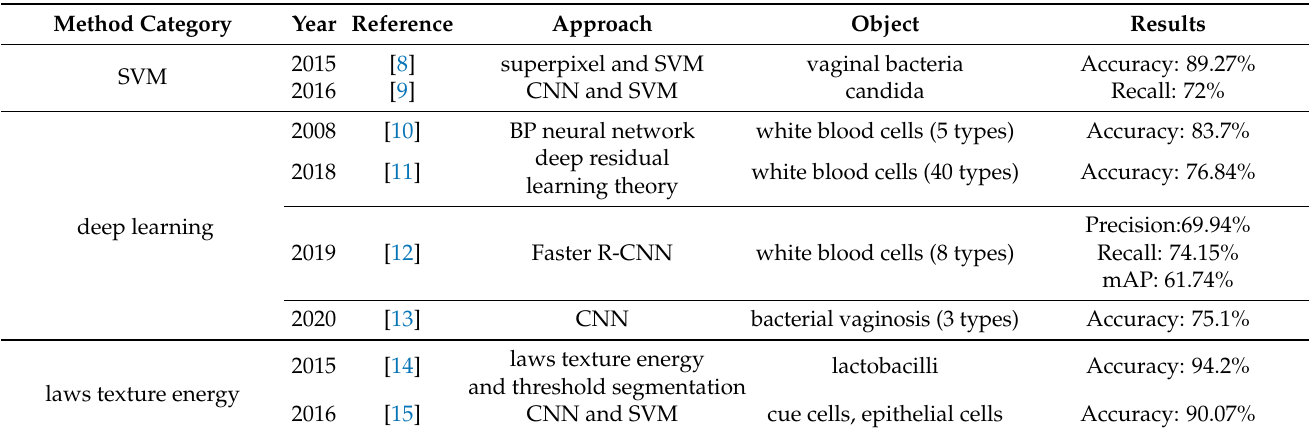
Table 1. Recent literature on CAD for